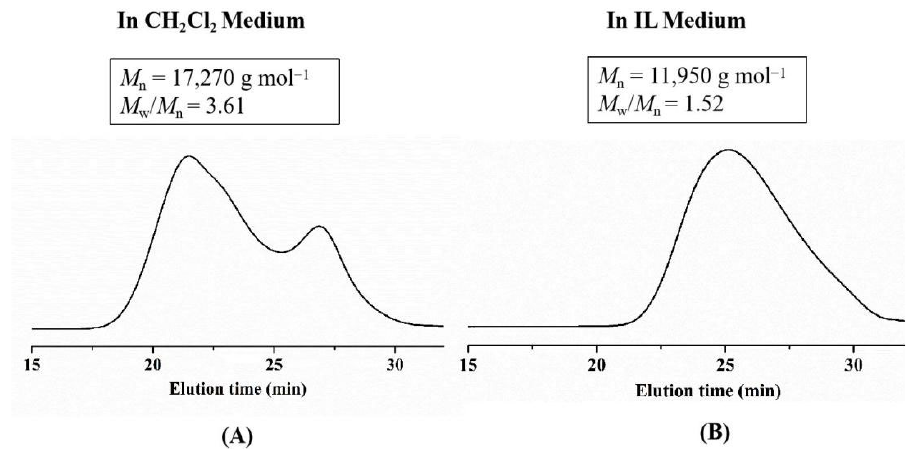
Figure 1. GPC traces for p ‐ MeSt polymerization with p ‐ MeStCl/SnCl 4 initiating system in CH 2 Cl 2 ( A ) and [Bmim][NTf 2 ] ( B ).